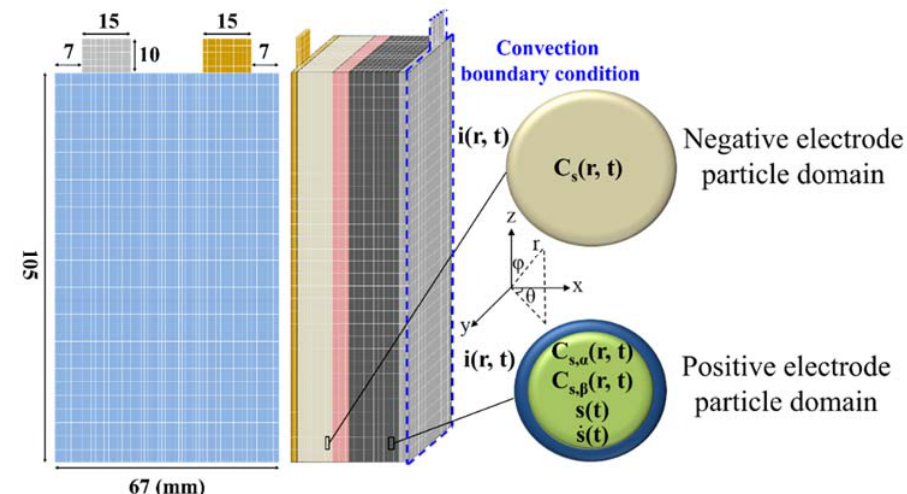
Figure 11. Schematic diagram and mesh configuration for the large LIB geometry of 10.5 cm × 0.67 cm wherein the current collecting tabs of the LIB are also considered on the negative and positive sides.